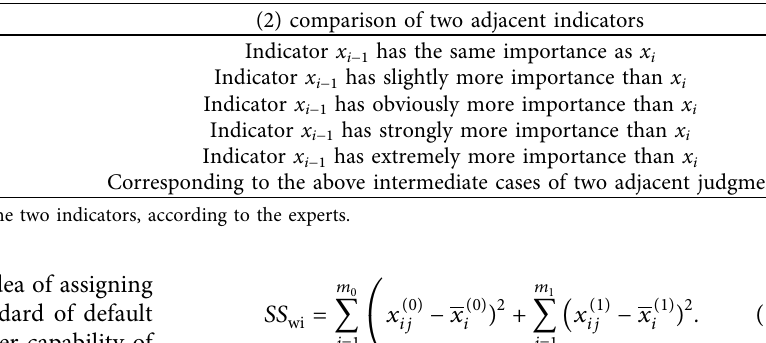
Table 2: Value of ratio r